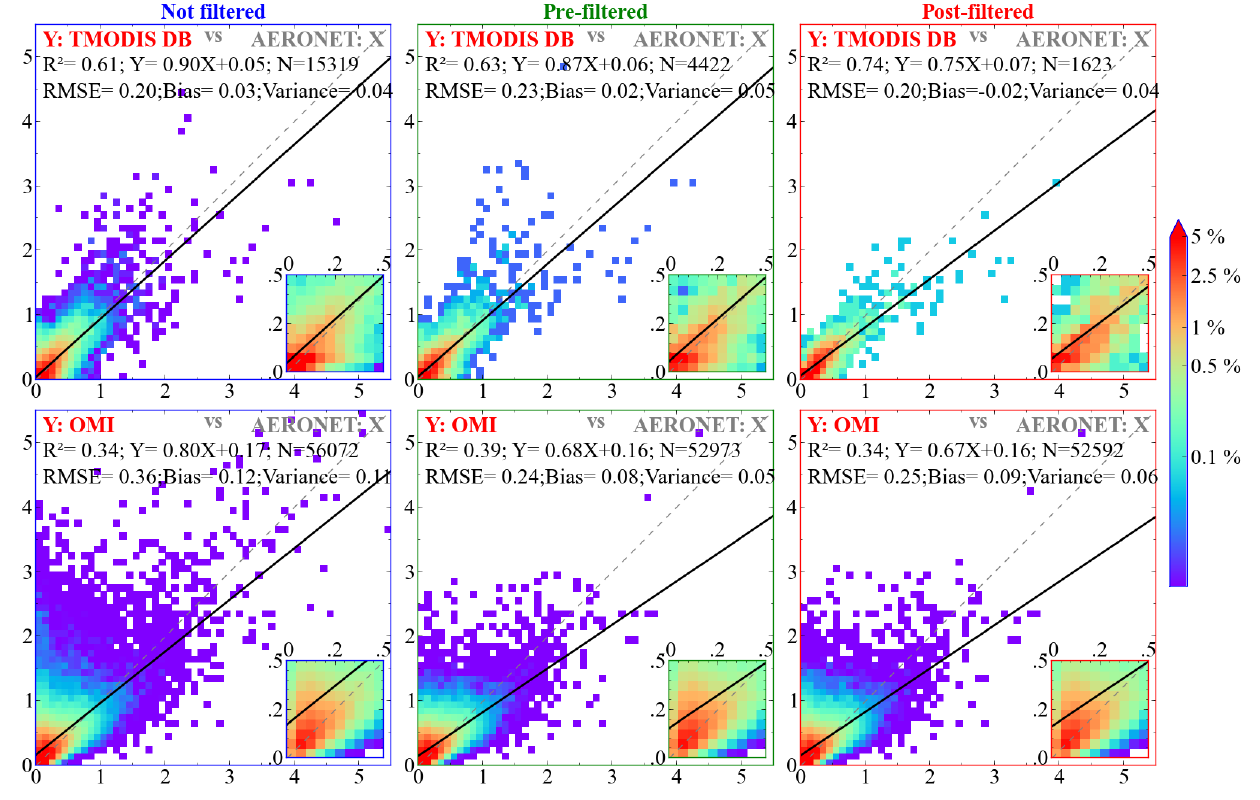
Fig. 4. Effects of two different data QA filtering schemes on the accuracy of the global collocated spaceborne AOD, as discussed in Sect. 4. AERONET AOD data are shown on the x axes, while AODs measured by spaceborne sensors are on the y axes. Density plots bin data into 0.1 AOD (0.05 AOD in magnified insets) intervals, where the color of each bin indicates the percentage of all data points that fall into this bin. Left column displays the original unfiltered data with all QA values. Middle column displays the data pre-filtered by QA, where individual pixels in each data sample were filtered based on their QA values before calculating the mean value of the sample. Right column shows the data post-filtered by QA, where the mean of each sample was calculated based on all pixels in the sample; after this, the whole sample was rejected if at least half of the pixels in the sample had QA values below the specified threshold. Note that OMI data have somewhat better properties when pre-filtered, while Terra MODIS–Deep Blue data are in a better agreement with AERONET AOD when post-filtered. The insets (0–0.5 AOD range magnified) are intended to enhance the visualization of the linear regression fits near the